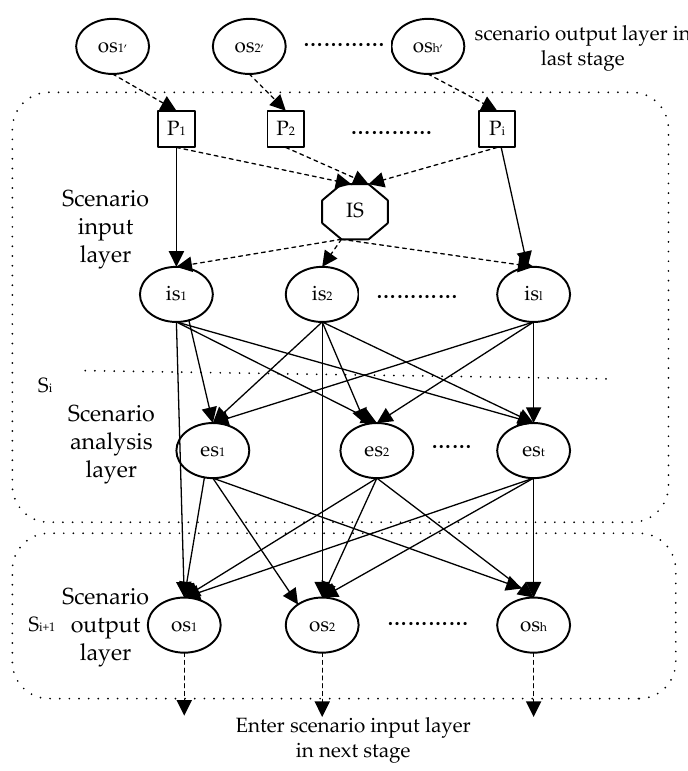
Figure 5. Deduction network of WEE scenarios.